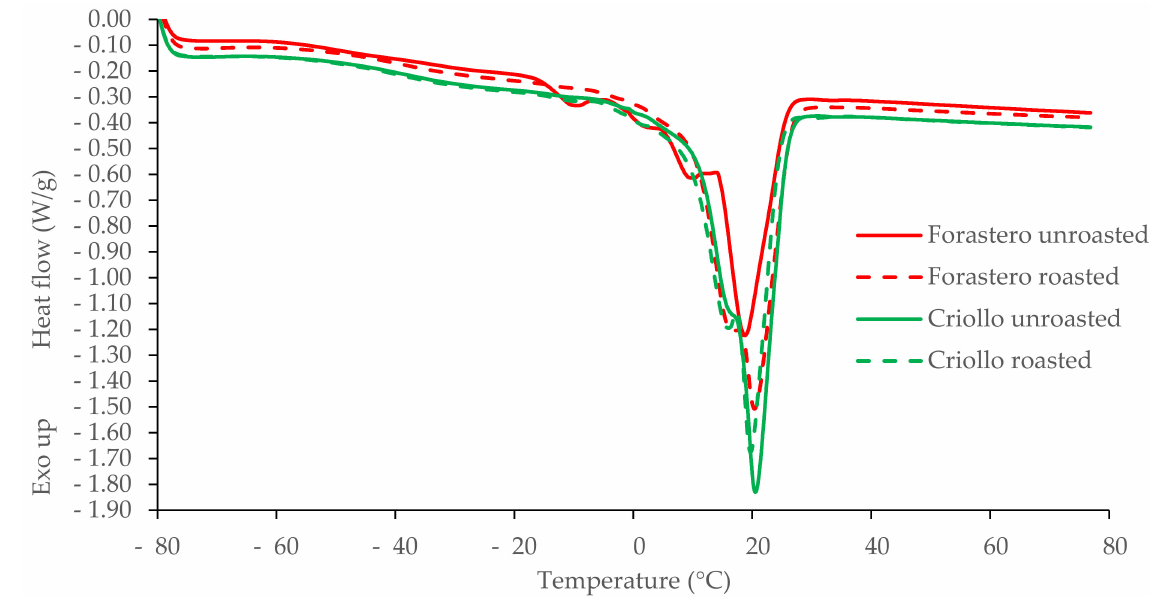
Figure 2. DSC melting curves of fats extracted from roasted and unroasted, Criollo (Peru) and Forastero (Ecuador) cocoa beans.